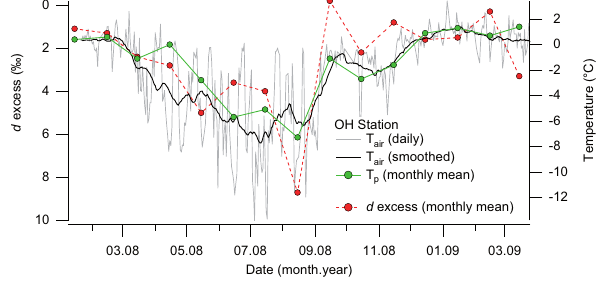
Fig. 11. Monthly d excess mean (red dots) of precipitation samples from O’Higgins station and daily air temperature ( T air , light grey). The smoothed T air (black line) correspond to a 30 day running mean function. For visualization purposes the d excess axis has been in-